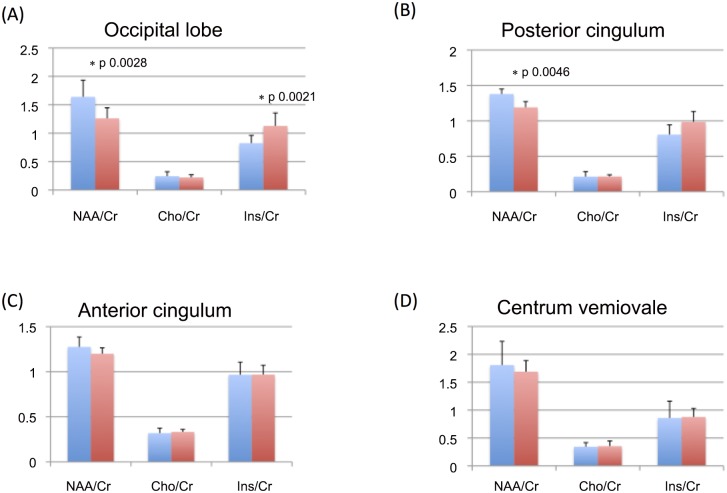
Column graphs showing mean and standard deviations of 1H MRS metabolite ratios (NAA/Cr, Cho/Cr and Ins/Cr) form the different VOIs in patients with PCA (orange) and healthy controls (blue).In the case of bilateral VOIs (i.e., occipital lobe and centrum semiovale), left and right measures were averaged. PCA patients compared to controls showed a significant decrease of NAA/Cr in the occipital lobes (panel A) and in the posterior cingulate gyrus (panel B). Additionally, PCA patients showed a significant increase of Ins/Cr in the occipital lobes (panel A). No significant between group differences were observed in the anterior cingulum (panel C) and in the centrum semiovale. Statistical threshold: p>0.012 after Bonferroni’s correction. See text for further details.